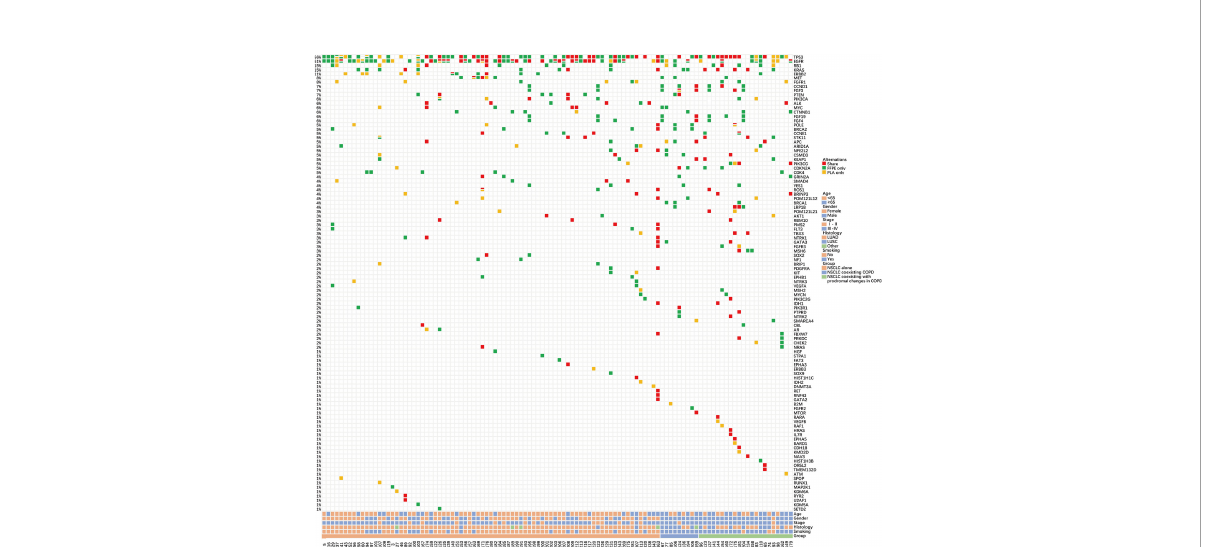
FIGURE 3 Summary of NSCLC patient characteristics and gene mutations in the matched FFPE tDNA and PLA ctDNA sample pairs. Different colors denote different degrees of gene mutation consistency. The percentage on the side represents the percentage of patients carrying a certain mutation. Bottom bars provide information regarding the age, sex, stage, histological diagnosis, smoking history, and